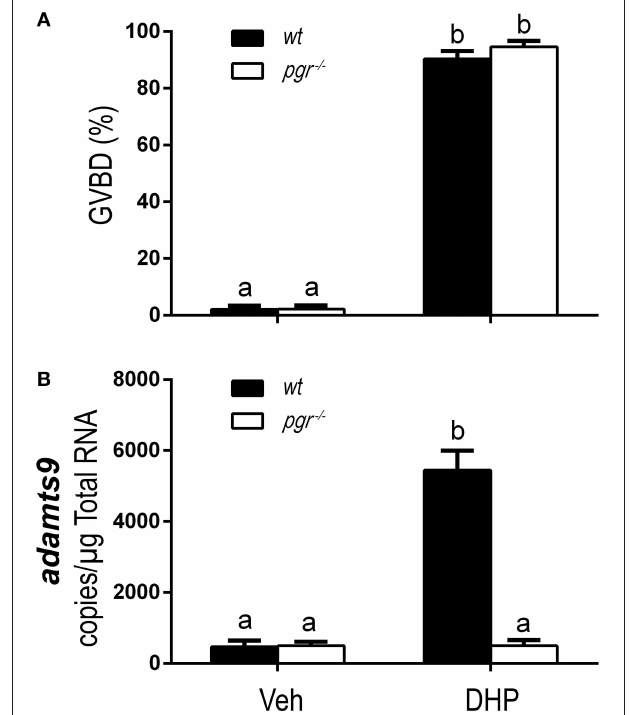
FIGURE 8 | Complete inhibition of DHP induced adamts9 expression in stage IVa follicles from Pgr knockout zebrafish in an in vitro incubation indicates a direct regulation of progestin in metalloproteinase. (A) Percentage of germinal vesicle breakdown (GVBD), (B) Expression of adamts9 transcript. White bar, pgr − / − ; black bar, wt . Different letters on the bars indicate significant differences ( p < 0.05). Experiment was repeated three times with results of one representative experiment presented as mean ± SEM. N = 4.